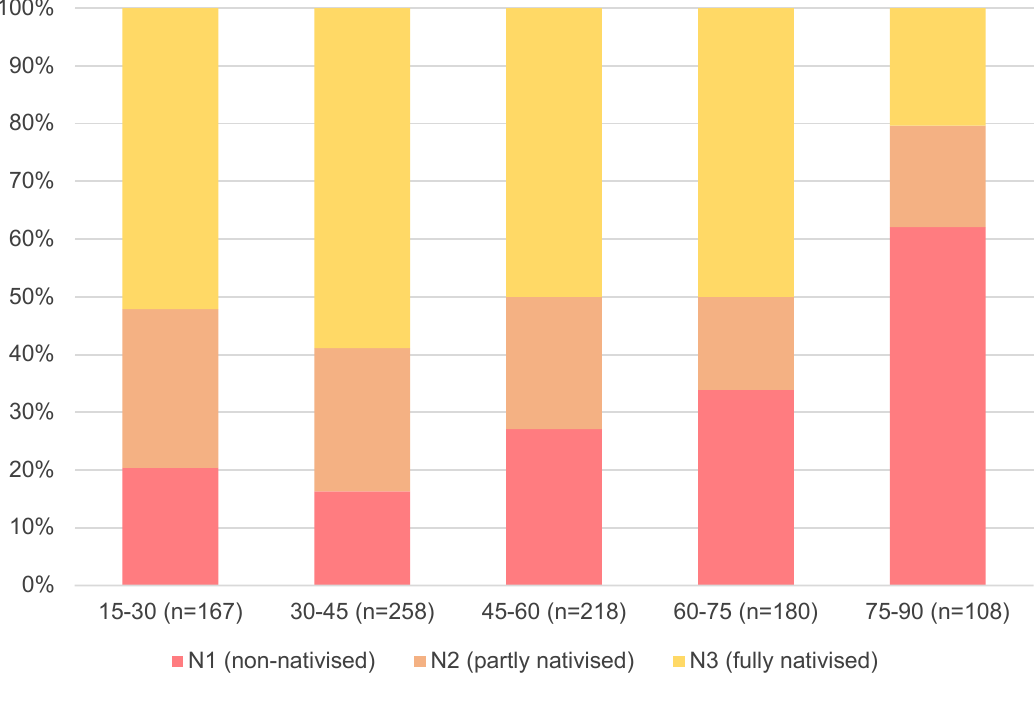
Figure 14: Distribution of fingerspelling-related tokens by nativisation category (N only) and age bracket